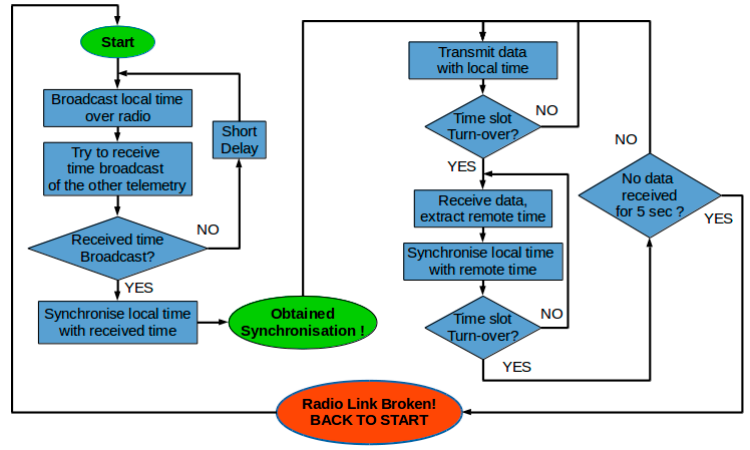
Figure 6. TDM process flow chart.